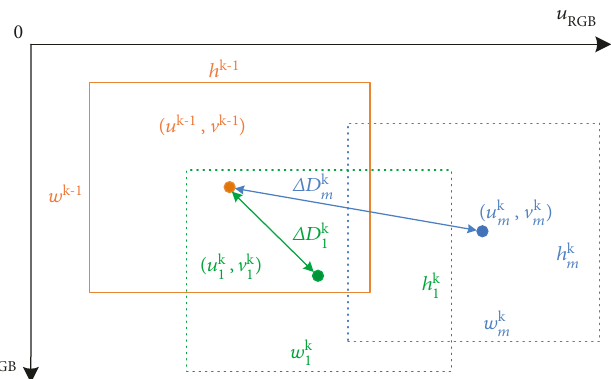
Figure 14: Geometric similarity matching of bounding box in color image.